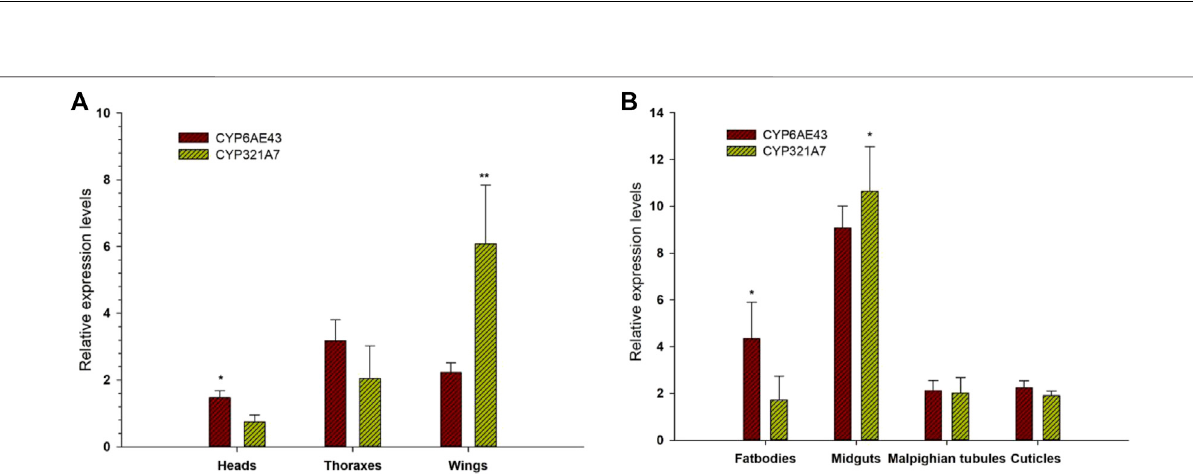
FIGURE3| Tissuespeci fi cexpression patternofCYP6AE43andCYP321A7inmidguts, bodies,malpighiantubulesand cuticlesofFAWlarvae (A) andtheheads, thoraxes and wings of adults (B) . Data shown are means ± SE derived from three biological replicates. Bars represent relative expression (mean ± SE). All biological groups contained three replicates for each treatment, and there were three technical replicates. The relative expression was calculated using the 2 − ΔΔ CT method based on the value of the egg expression, which was ascribed an arbitrary value of 1. The astriks on the bar represent signi fi cant differences ( p < 0.05) using one-way ANOVA, followed by Tukey ’ s HSD multiple comparison